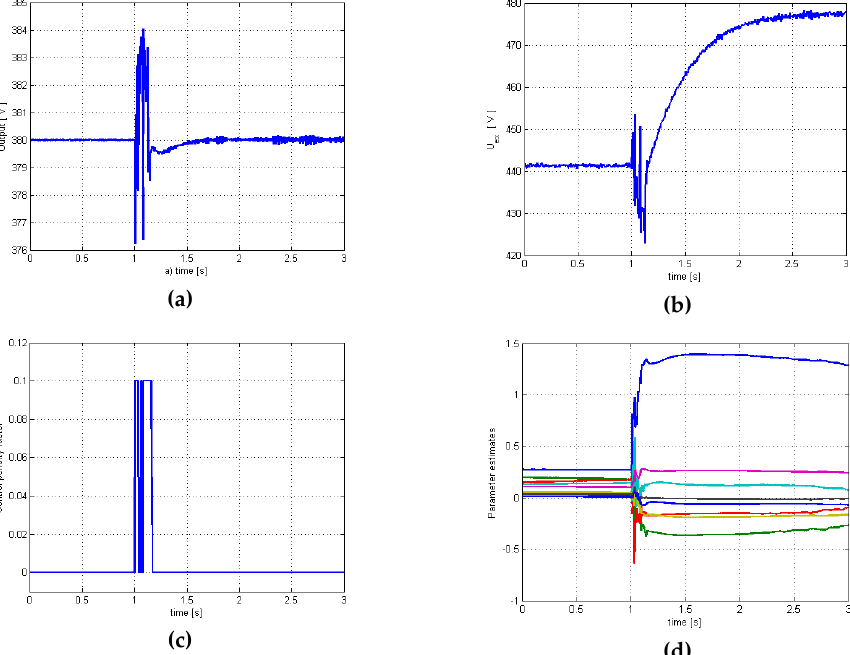
Figure 4. (a) Controlled output (terminal voltage) —(cid:2025) ∈ {0.0001, 0.1} ( (cid:1986)(cid:1846) (cid:3040) = 17% ); (b)